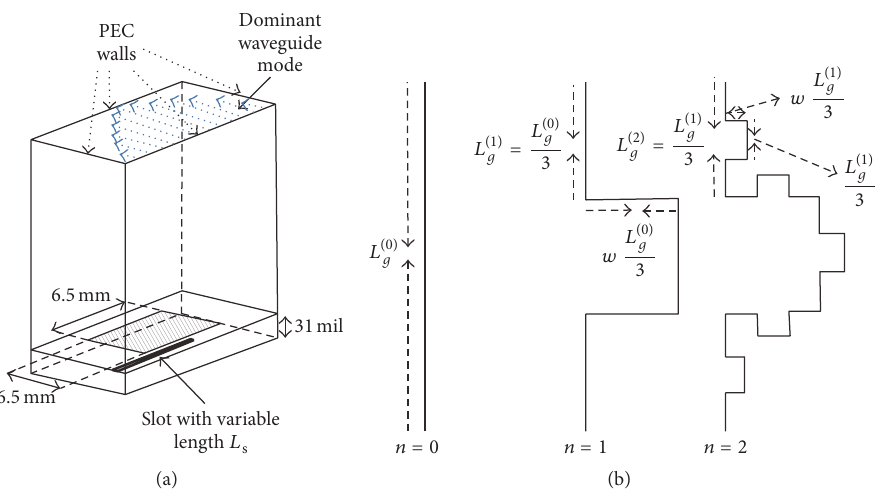
Figure 4: (a) Simulated reflectarray patch-slot unit cell; (b) generation procedure for the Minkowski fractal curves with 𝑛 = 0, 1, 2 corresponding to the generator, 1st and 2nd Minkowski configurations.